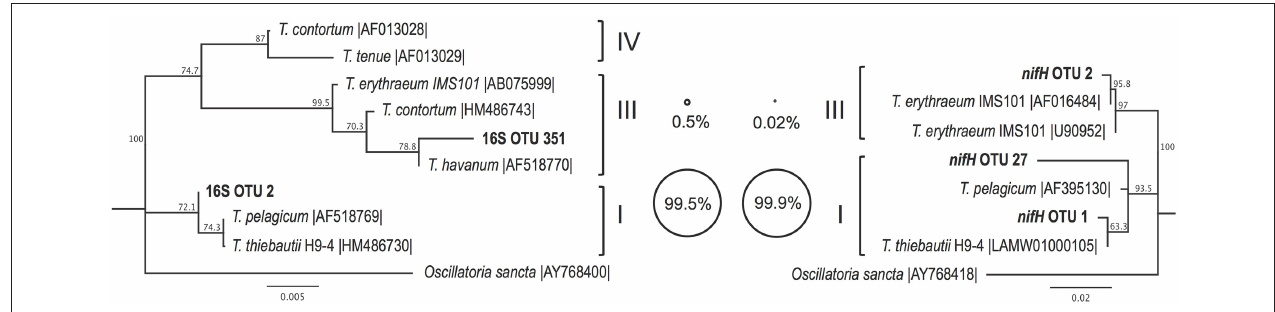
FIGURE 2 | Neighbor joining phylogenetic trees depicting the relationships between Trichodesmium OTUs (97% nucleotide similarity) from partial 16S rRNA (left) and partial nifH (right) gene sequences, together with reference sequences from cultivated representatives (accession numbers given). Major Trichodesmium clades (Lundgren et al., 2005) are shown in Roman numerals. Bubble plots depict the percentage of Trichodesmium DNA sequences from this study which group with each clade, according to partial 16S rRNA (left) and partial nifH (right) amplicon datasets. Bootstrap values (1,000 replicates) of > 50% are provided. Scale bars represent nucleotide substitutions per site.